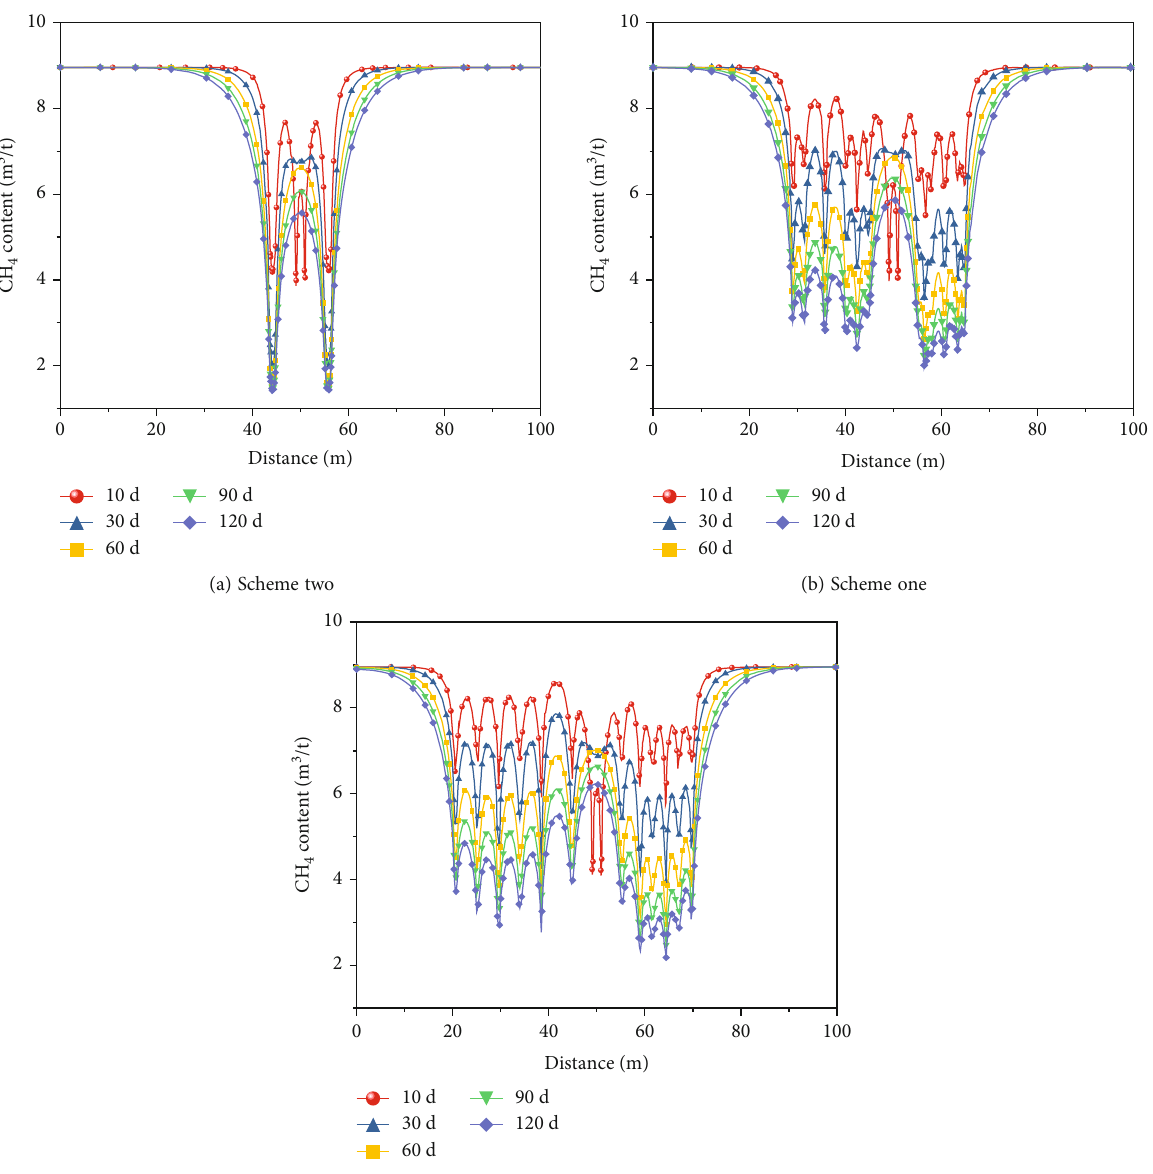
Figure 3: Evolution curve of gas content on reference line AB under di ff erent arrangements of included